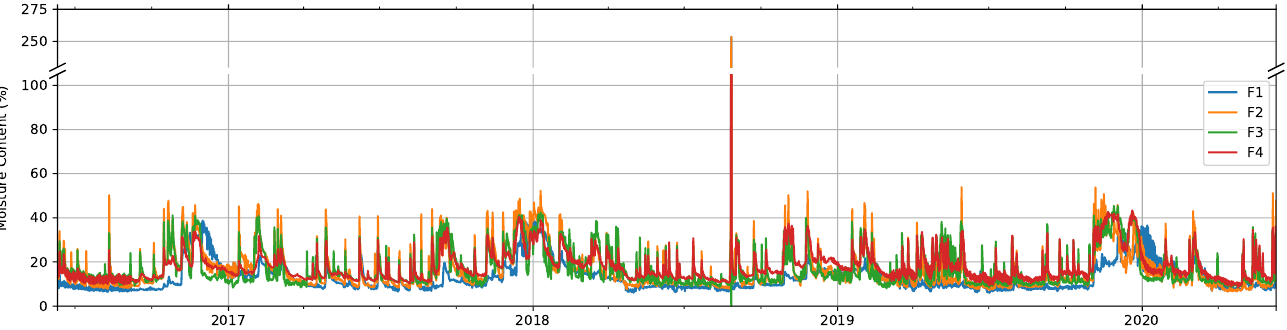
Figure 6. Computed moisture content (%) for four of the signals measured on the facade.